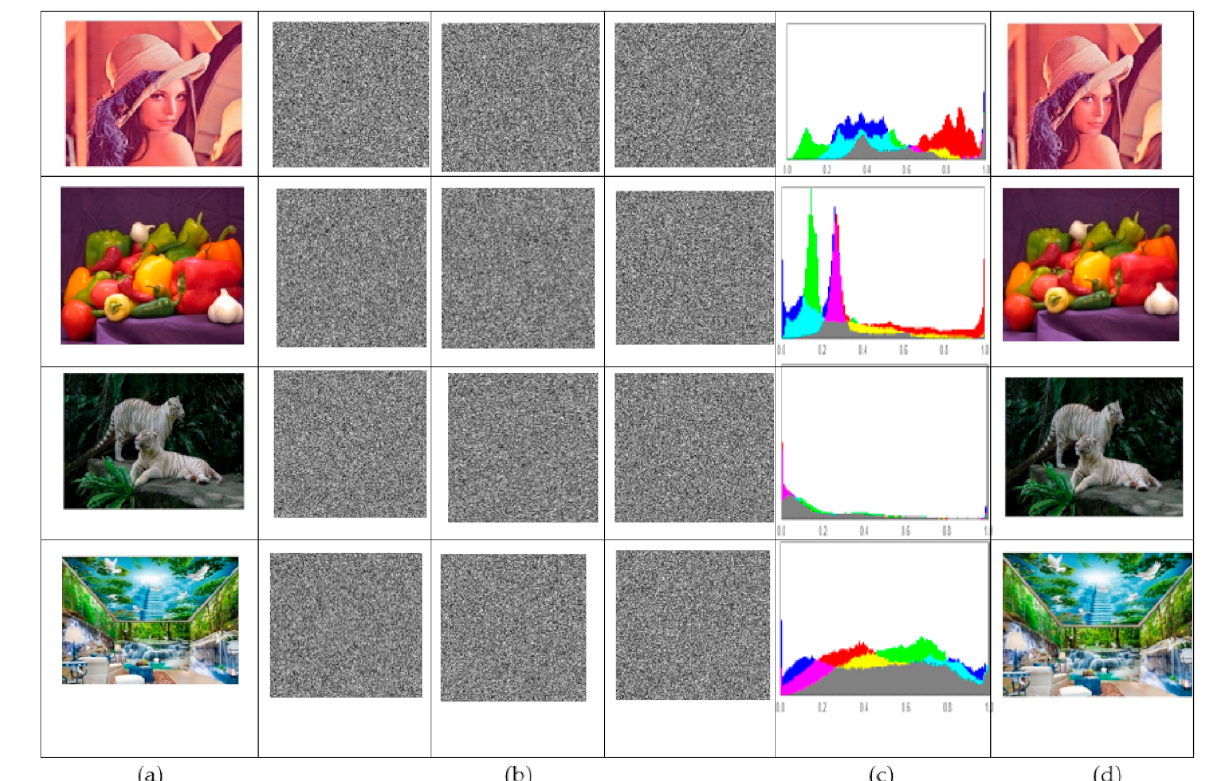
Figure 7. Histograms of colored plain images. ( a ) Original Plain images. ( b ) Cipher images. ( c ) Histograms of original plain images. ( d ) Decrypted plain